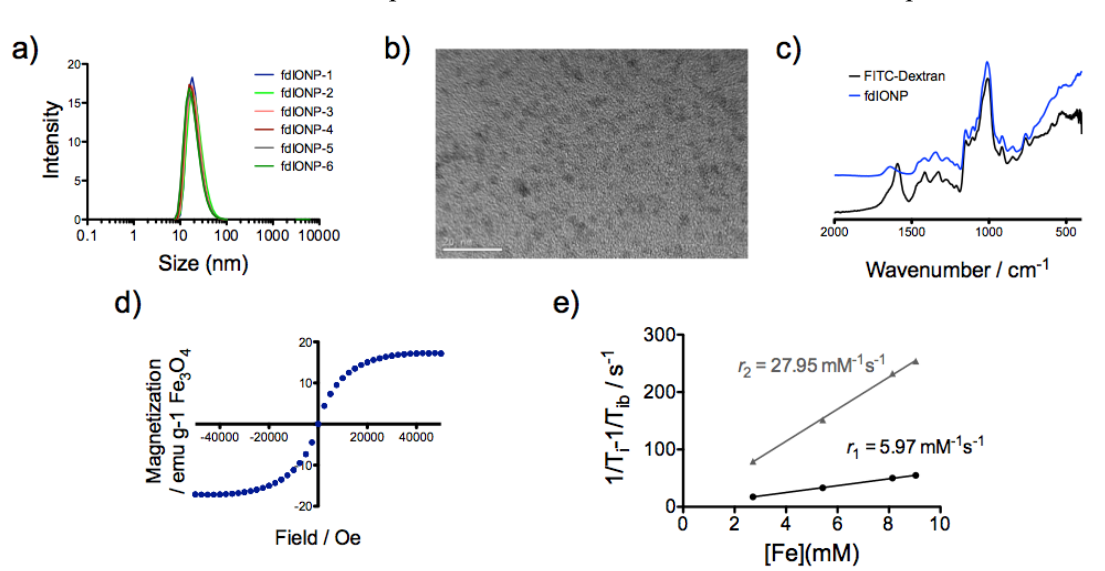
Figure 1. Physicochemical characterization of fdIONP. ( a ) Hydrodynamic size for fdIONP ( N = 6); ( b ) Transmission electron microscopy (TEM) image of fdIONP; ( c ) Fourier transform infrared spectroscopy (FTIR) spectrum for fdIONP; ( d ) Field dependent magnetization of fdIONP and ( e ) Relaxivities ( r 1 and r 2 ) measurements for fdIONP in water at 37 °C and 1.5